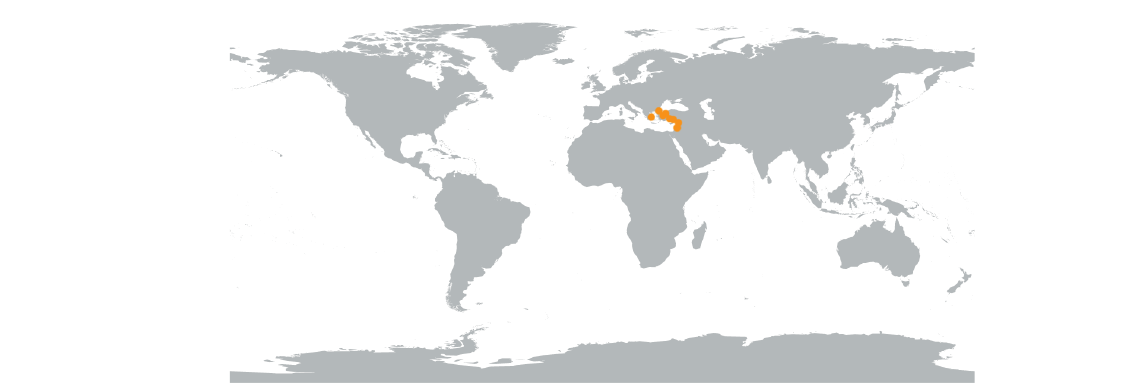
Fig. 55. Distribution of Malus trilobata (Labill. ex Poir.)